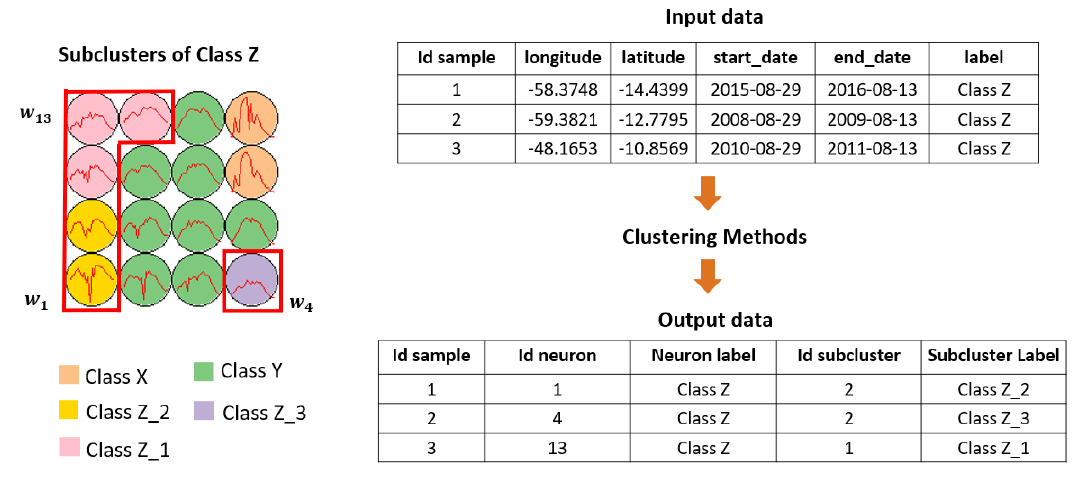
Figure 3. Clustering output. The red lines in the self-organizing maps (SOM) grid represent the subclusters that were generated from the neurons labeled as class Z. For each sample of the dataset, an id and label of the neuron and an id and label of subclusters are assigned to each